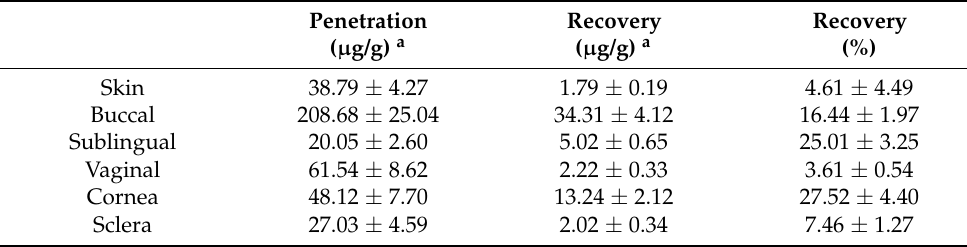
Table 4. Drug uptake (determined by the amount of drug that has penetrated the tissue) and recovery of BCT in the tissues tested. The sample analysis was carried out by spectrophotometry and/or fluorimetry depending on the sample concentration. Penetration Recovery Recovery ( µ g/g) a ( µ g/g) a